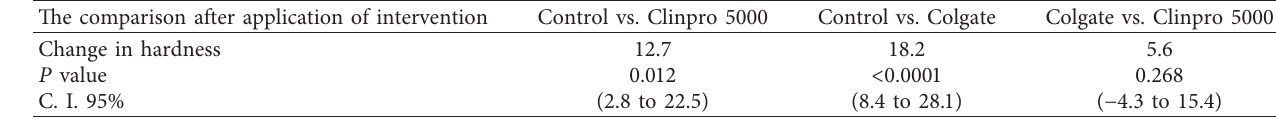
Table 2: Predicting Hardness by type of intervention via mixed-effects model.